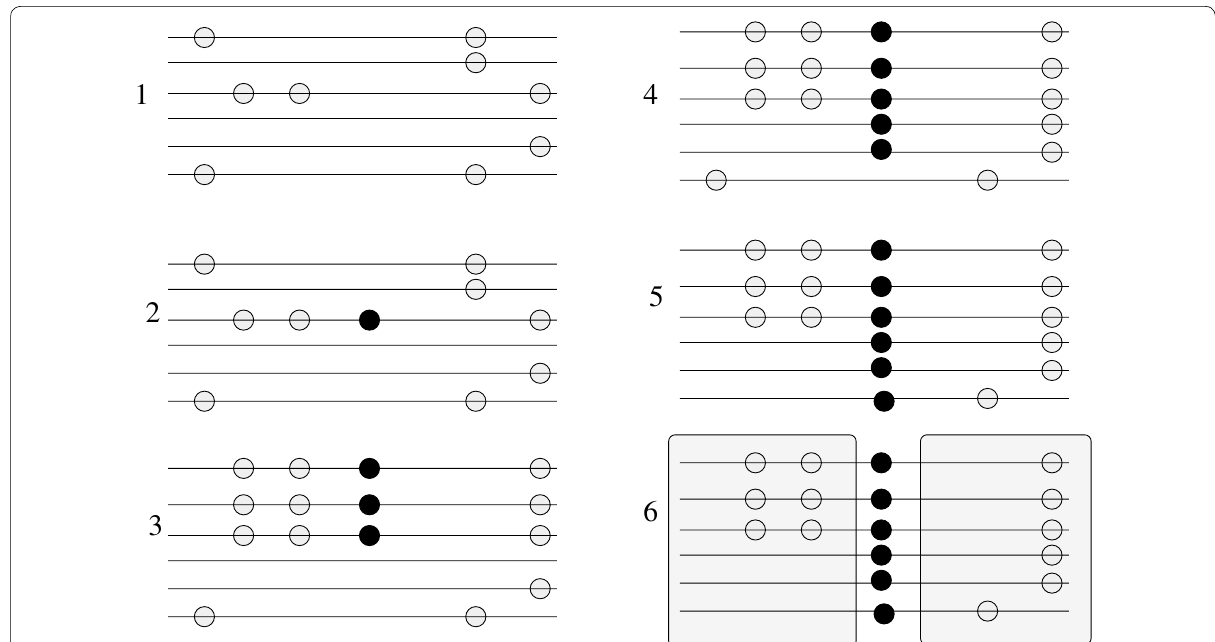
Fig. 2 The LD signature around a selective sweep. Assume a population with neutral segregating variation ( 1 ). A beneficial mutation occurs (shown as a black allele) in subfigure ( 2 ). Since the mutation is beneficial, its frequency will increase in the population. Neutral variants that are linked to the beneficial mutation will hitchhike with it ( 3 ). Due to recombination, mutations from a neutral background will get linked with the beneficial mutation ( 4 , 5 ). Finally, the selective sweep completes ( 6 ). The LD pattern that emerges from such a process is the elevated LD on each side of the beneficial mutation and the decreased LD for SNPs that are on different sides of the beneficial